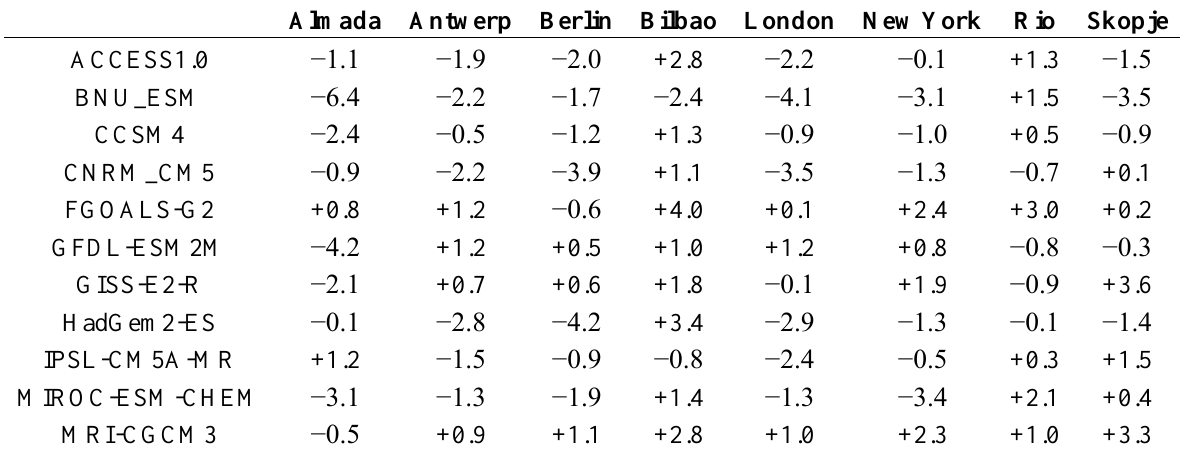
Table 4. Overview of the magnitude of the applied bias correction (in °C) on the domain-wide mean temperatures for the reference period (1986–2005) for all models and cities. Almada Antwerp New York Skopje